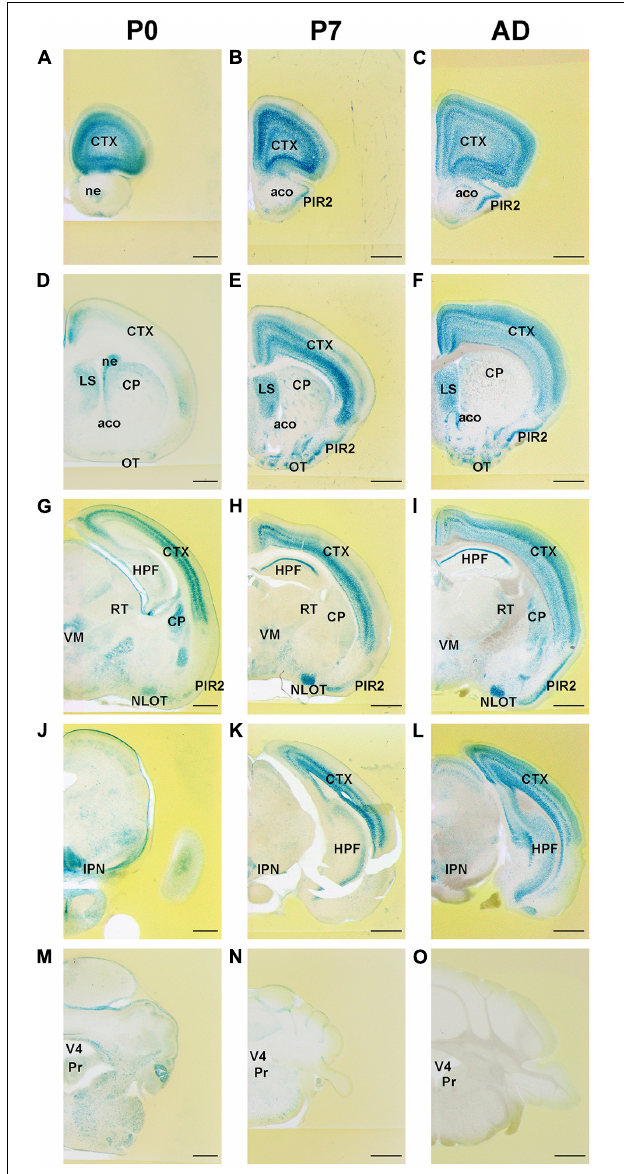
FIGURE 1 | Expression pattern of Flrt2-lacZ in the postnatal stages of brain development. Flrt2-lacZ expression was observed on the planes of the prefrontal cortex (A–C) , LS (D–F) , HPF (G–I) , midbrain (J–L) , and cerebellum (M–O) at P0 (A,D,G,J,M) , P7 (B,E,H,K,N) , and adulthood (C,F,I,L,O) . aco, anterior commissure, olfactory limb; ACB, nucleus accumbens; CP, caudate putamen; CTX, cerebral cortex; HPF, hippocampal formation; IPN, interpeduncular nucleus; LS, lateral septal nucleus; ne, neuroepithelium; NLOT, nucleus of the lateral olfactory tract; OT, olfactory tubercle; PIR2, piriform area, pyramidal layer; Pr, prepositus nucleus; RT, reticular nucleus of the thalamus; VM, ventral medial nucleus of thalamus; V4, fourth ventricle. Scale bars, 500 µ m (A,D,G,J,M) ; 1 mm (B,C,E,F,H,I,K,L,N,O) . n = 3, 3, and 4 for P0, P7 and adulthood, respectively.